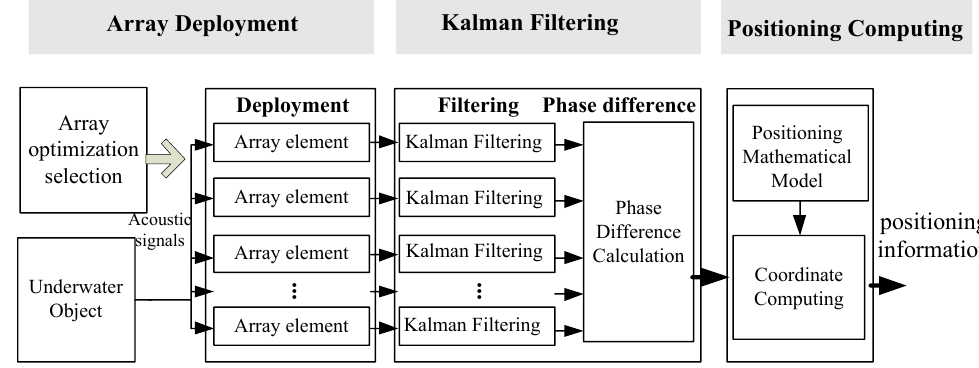
Figure 1. The framework of the ultra-short baseline (USBL) positioning system based on Kalman filtering.